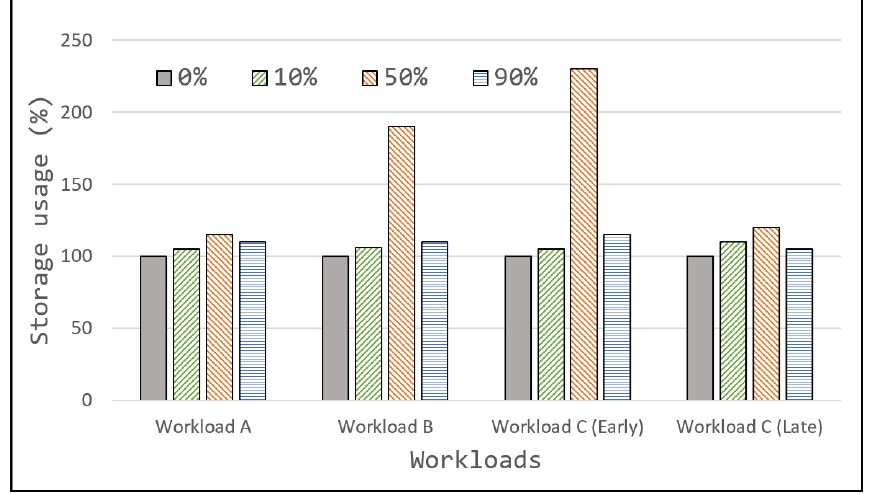
Figure 6. Storage